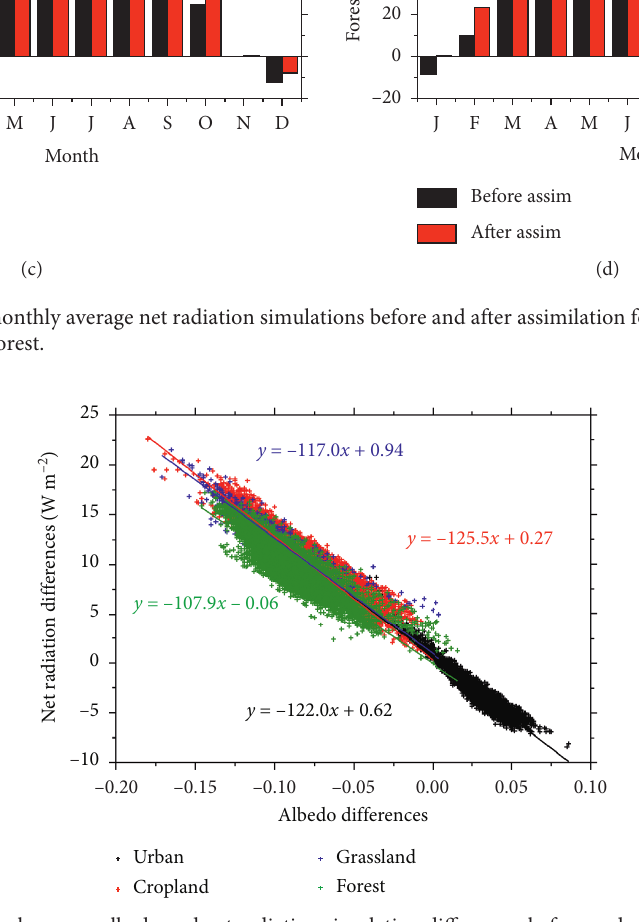
Figure 10: Scatter plot of the annual average albedo and net radiation simulation differences before and after assimilation for the four main LUCs (after assimilation minus before assimilation).